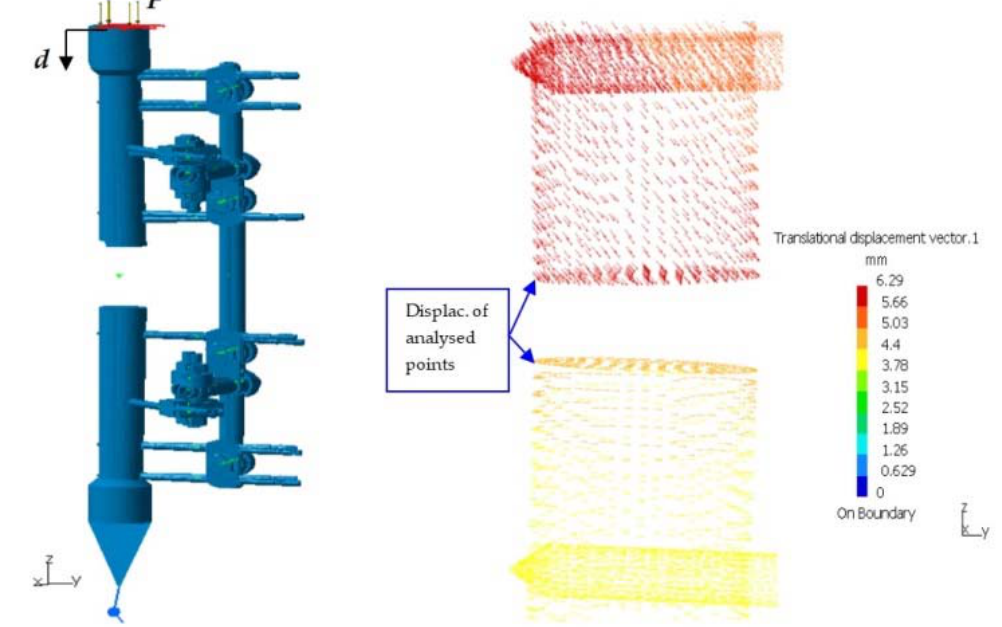
Figure 5. Non-deformed and deformed structures of the fixator under maximum axial load and interfragmentary displacements at the fracture.